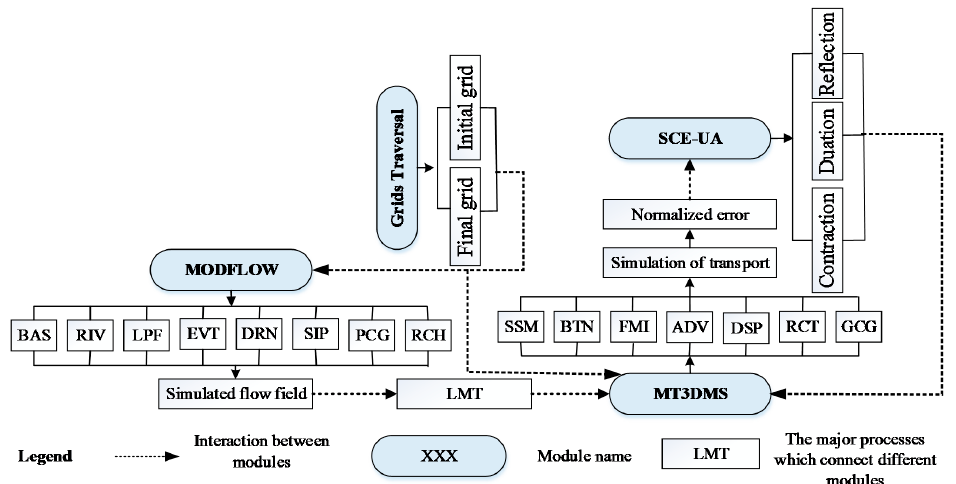
Figure 1. The model structure and the interactions among the major modules: Basic package(BAS), River package(RIV), Layer-Property Flow package(LPF), Evapotranspiration package(EVT), Drain package(DRN), Strongly-Implicit Procedure package(SIP), Preconditioned Conjugate-Gradient package(PCG), Recharge package(RCH), Sink & Source Mixing package(SSM), Basic Transport package(BTN), Flow Model Interface package(FMI), Advection package(ADV), Dispersion package(DSP), Chemical Reaction package(RCT), Generalized Conjugate Gradient Solver package(GCG) .